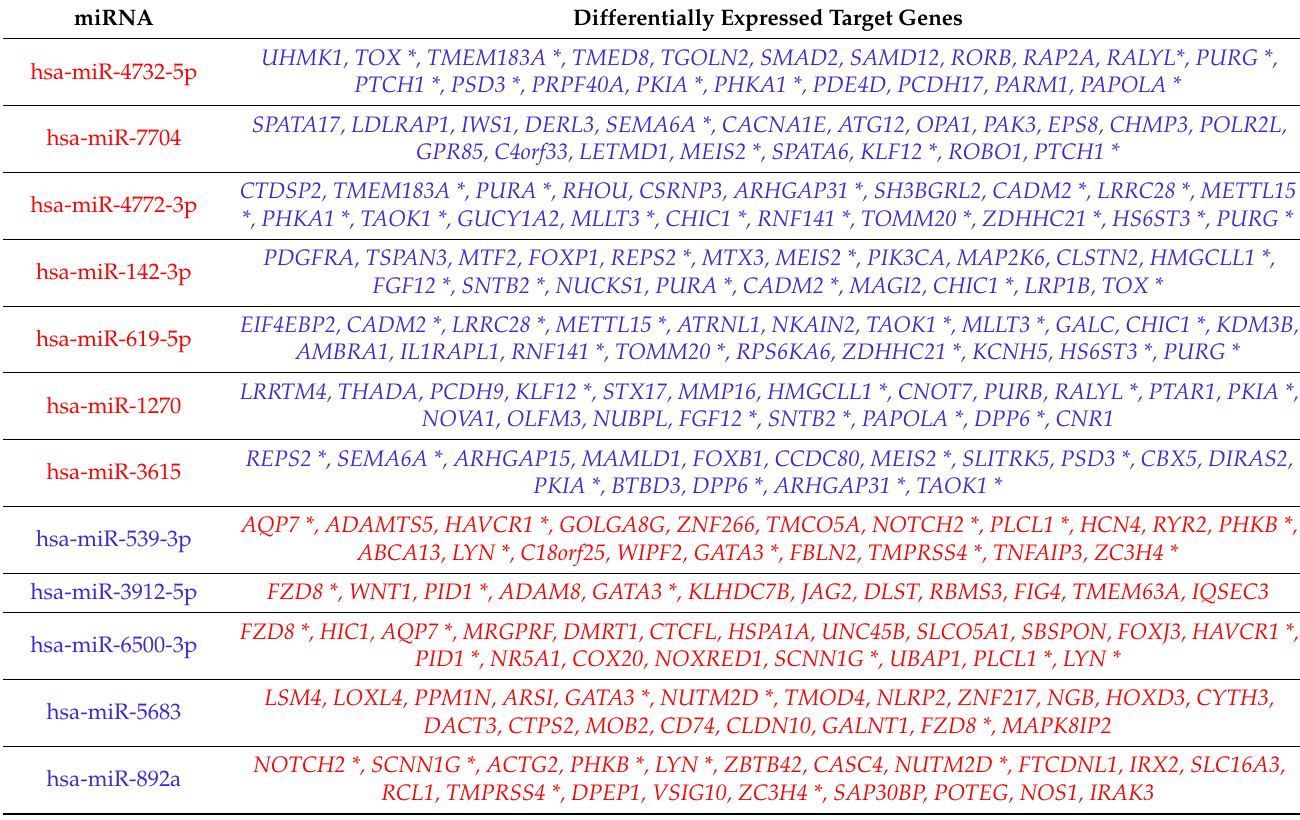
Table 3. Differentially (>2-fold change, FDR p < 0.05) expressed miRNA target genes in human stroke brain tissue. Red— upregulated and blue—downregulated miRNAs and genes. Target genes shared by at least 2 different miRNAs are marked with a